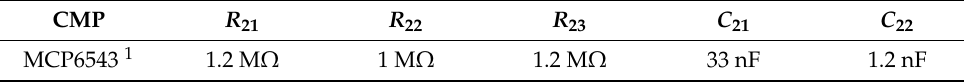
Table 2. Sampling parameters for each con fi guration.